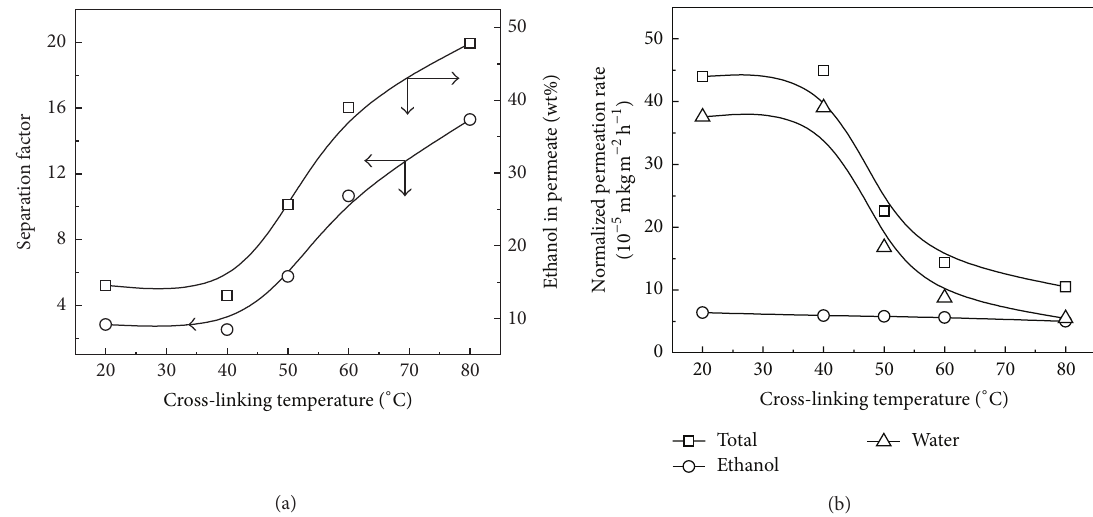
Figure 5: Effect of cross-linking temperature on (a) ethanol in permeate and (b) the normalized permeation flux for an aqueous solution of 6wt% ethanol through PDMS-VTOS membrane during PV (operating temperature: 40 ∘ C, the weight ratio of H-PDMS:VTOS :DBTDL is 1:0.2 :0.02).